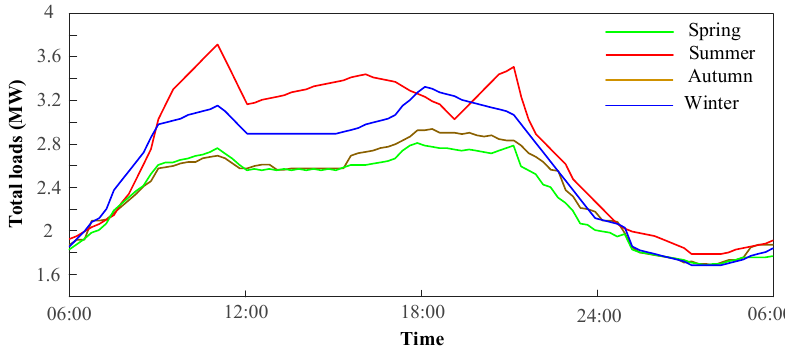
Figure 7. The daily load curves of the given network in different seasons [26].